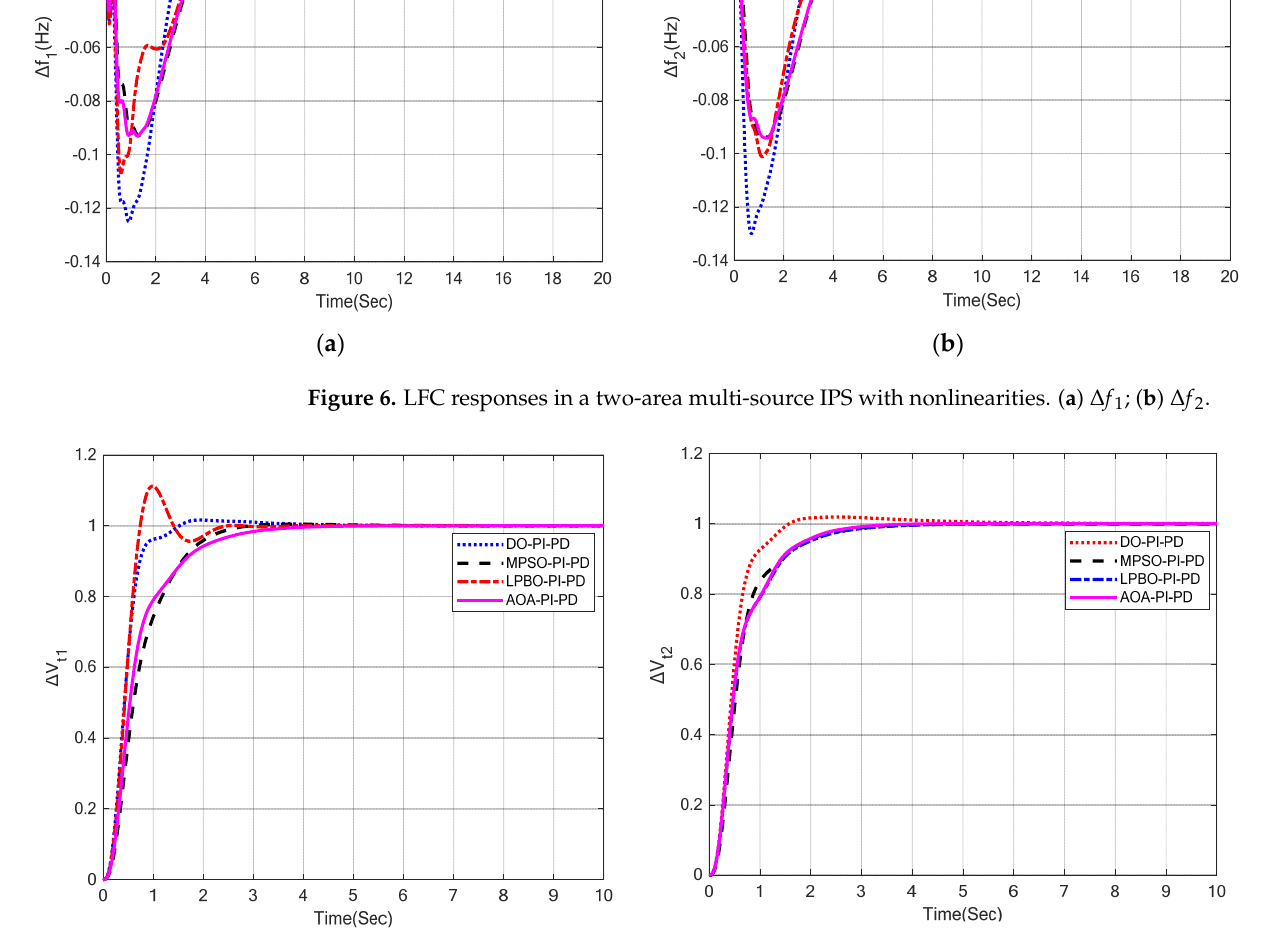
Figure 7. AVR responses in a two-area multi-source IPS. ( a ) V t1 ;( b ) V t2 . Table 5. Numerical results of an LFC in a two-area multi-source